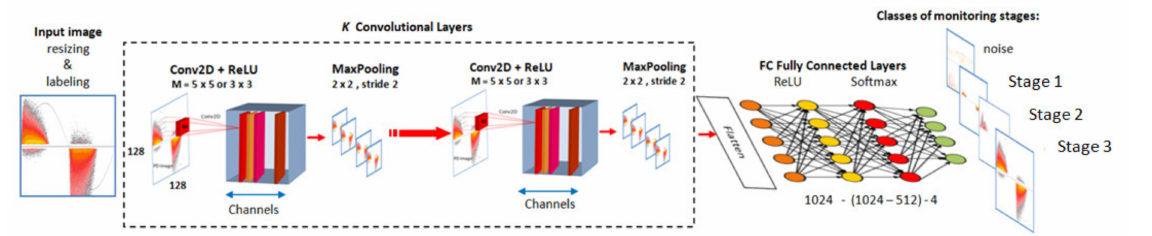
Figure 12. Convolutional neural network topology applied to PD patterns in monitoring application